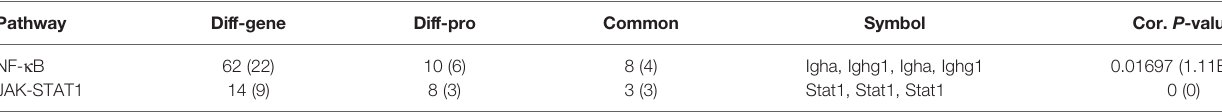
Group OC-vs.-MV is shown in brackets.